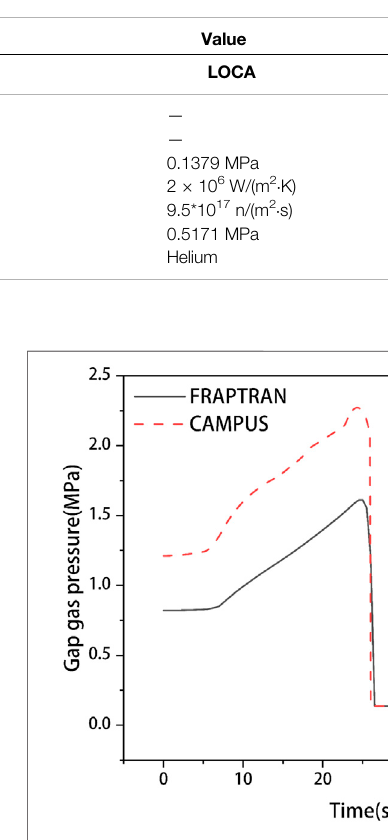
FIGURE 1 | Linear power history of the UO 2 fuel with Zircaloy cladding used to calculate the LOCA condition.